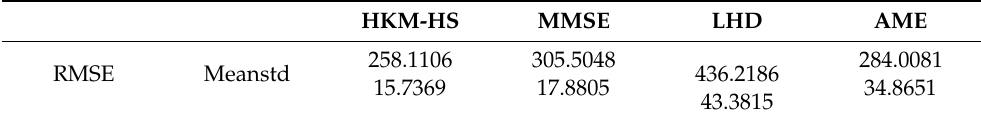
Table 6. Comparison of spring modeling